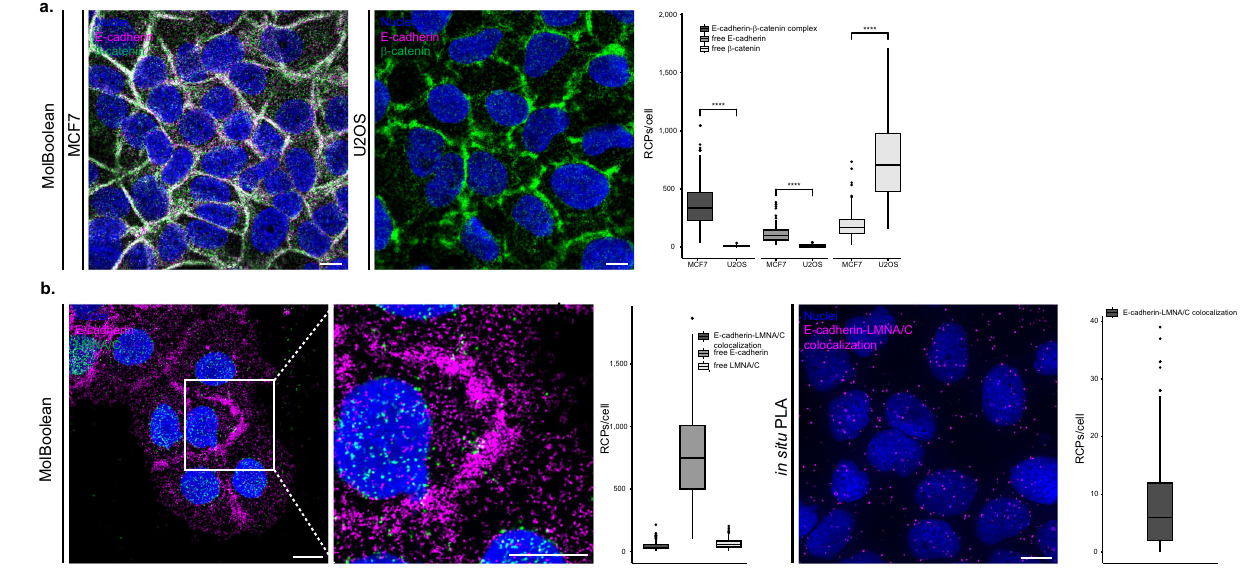
Fig. 3 | MolBoolean staining of E-cadherin with an interaction partner vs no- interaction partner. a Co-stain of E-cadherin which is differentially expressed in MCF7 (positive for E-cadherin) and U2OS cells (negative for E-cadherin) and interaction partner β -catenin. ( p =1.76e − 55; p =1.89e − 55; p =7.84e − 52 for E- cadherin- β -catenin complex, free E-cadherin, free β -catenin respectively). Mol- Booleansignals areshownfor E-cadherin (magenta), β -catenin(green),E-cadherin- β -catenin complex (white) and nuclei (blue). b E-cadherin and LMNA/C in HaCaT cells are expected not to colocalize. MolBoolean signals are shown for E-cadherin (magenta), LMNA/C (green), E-cadherin-LMNA/C complex (white) and